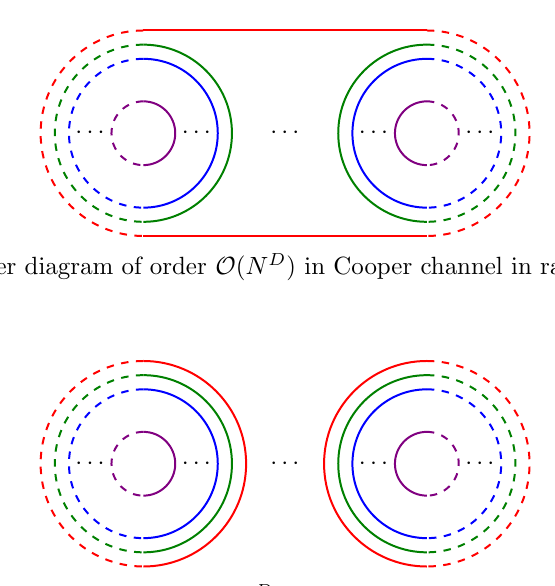
Figure 25. Unbroken and broken ladder diagrams of order O ( N D ) in Cooper channel in rank- D tensor